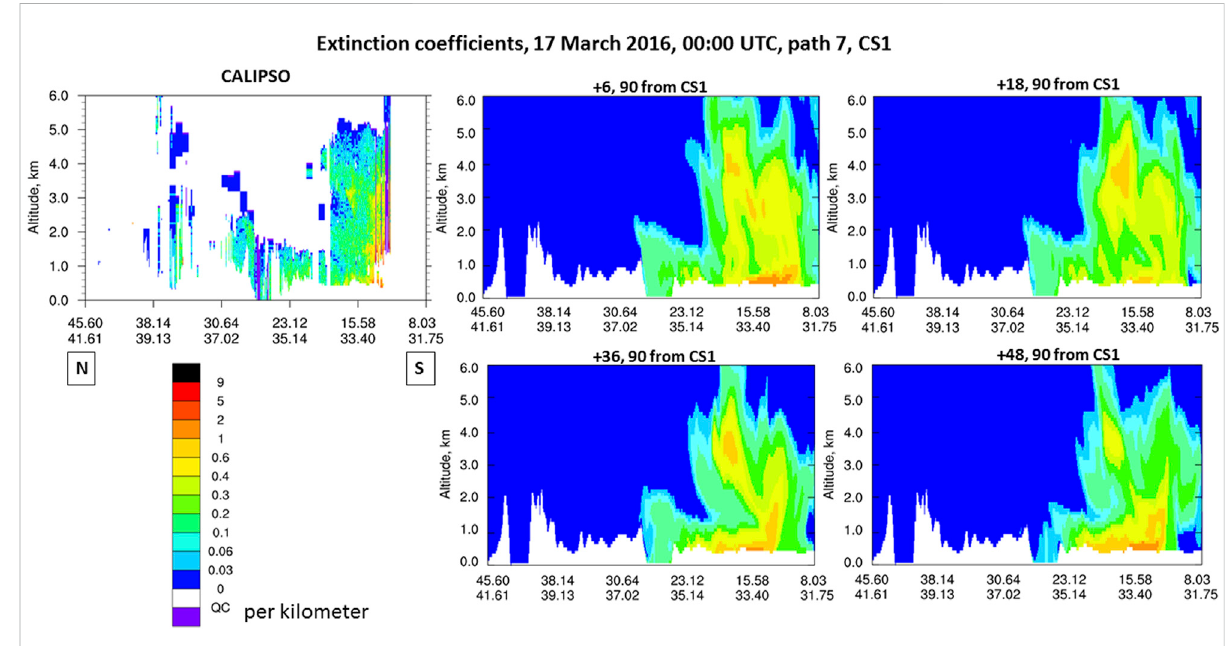
FIGURE 6 Same as Figure 5 except along CALIPSO Path #7 and valid at 00 UTC March 17.